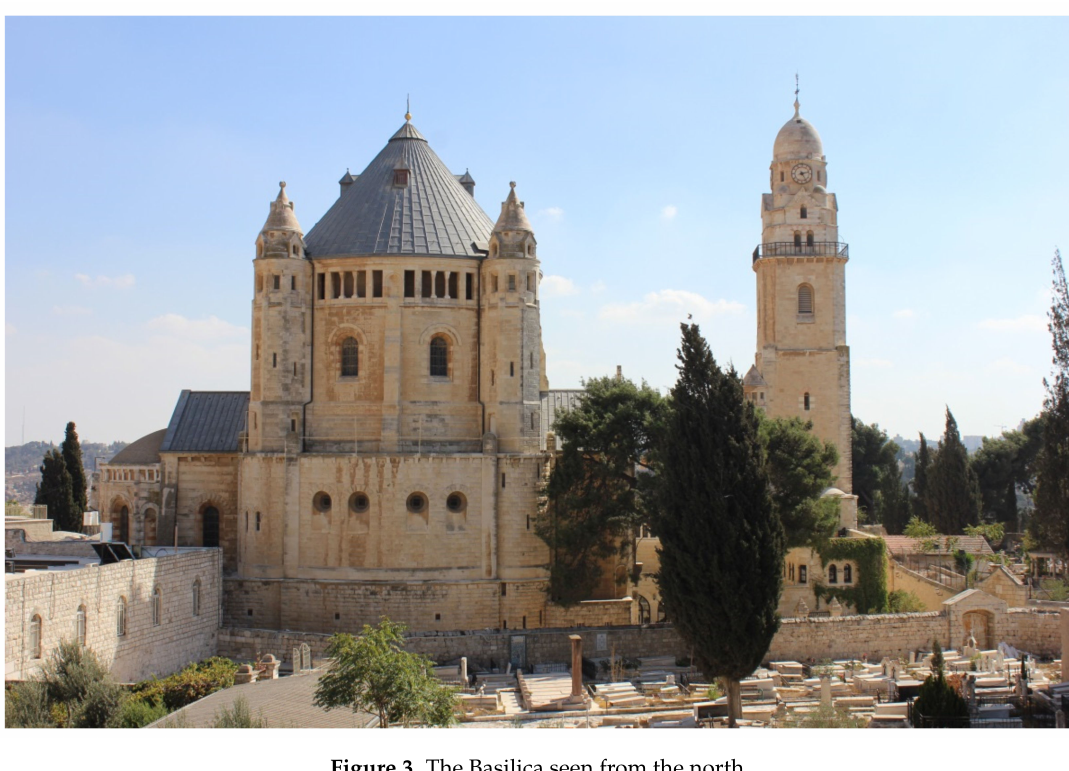
Figure 3. The Basilica seen from the north.